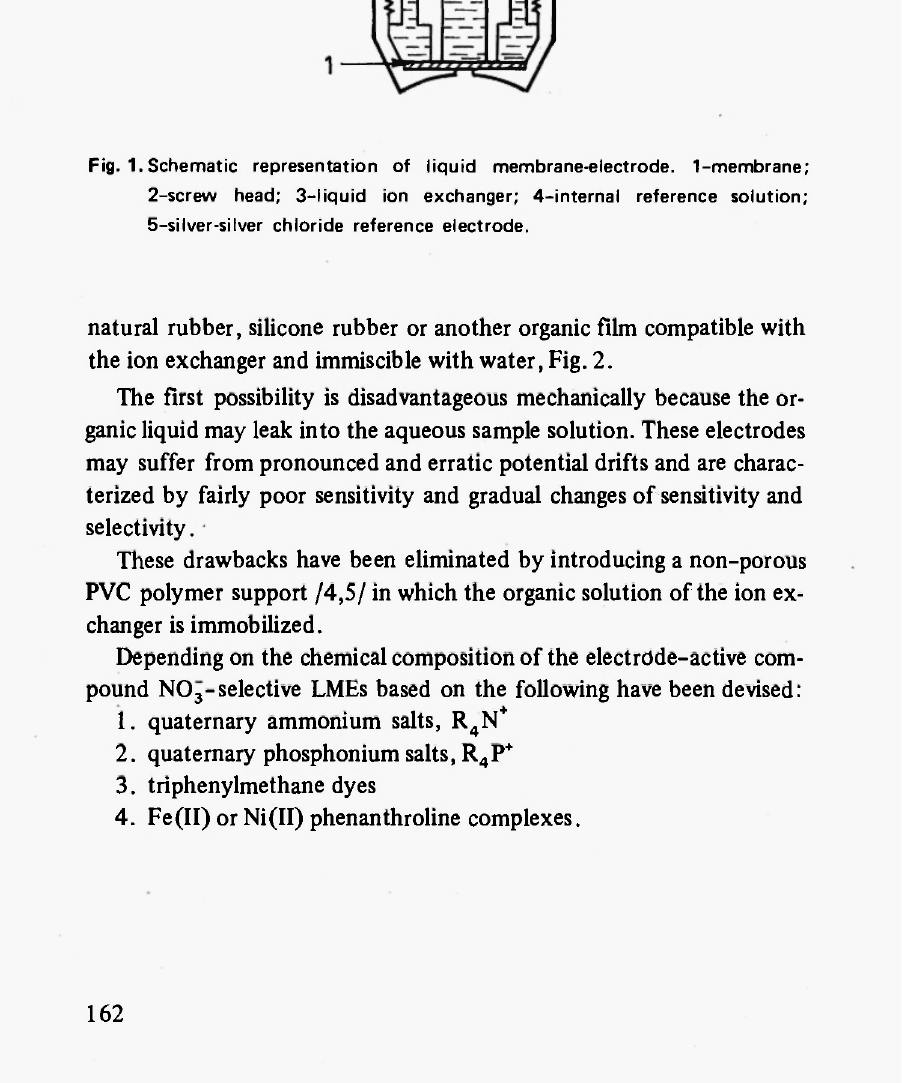
Fig. 1. Schematic representation of liquid membrane-electrode. 1-membrane; 2-screw head; 3-liquid ion exchanger; 4-internal reference solution; 5-silver-silver chloride reference